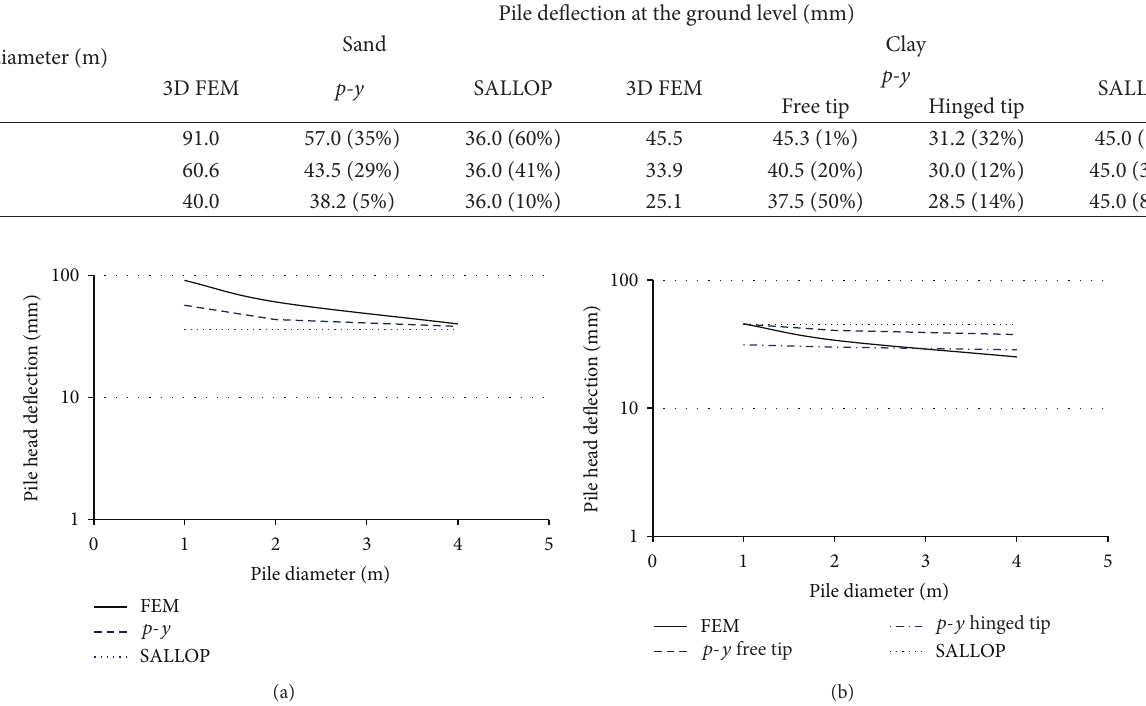
T 4: Variation of pile head displacement versus pile diameter in different nonlinear analysis methods with constant EI for the pile.